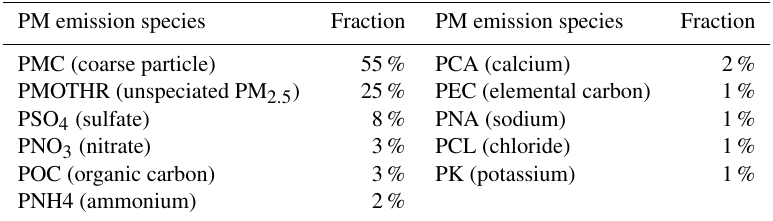
sula. Figure 7 (10:30 LST on 22 February) indicates massive dust over that area from the GOCI-derived AOD consistent with the enhanced PM 10 concentrations. The massive dust